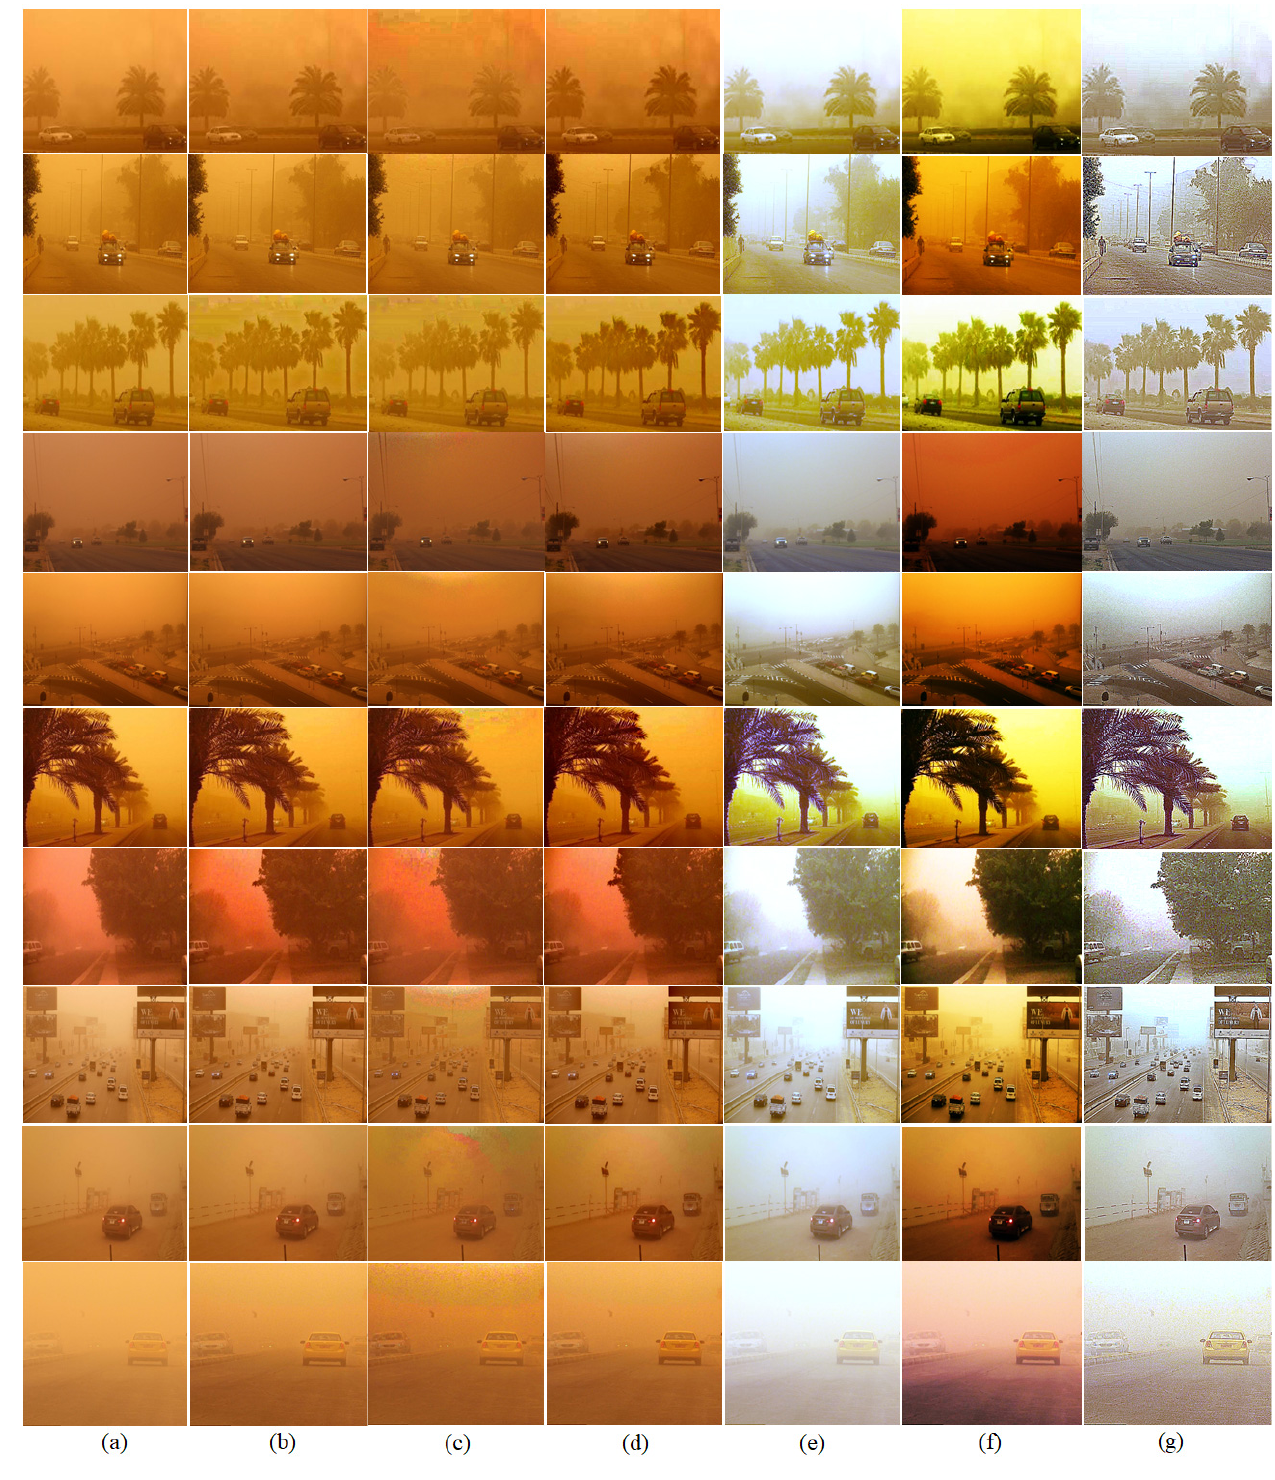
Figure 7. The comparison of the enhanced image with state-of-the-art methods and the proposed method on severely degraded duststorm images: ( a ) Input image; ( b ) He et al. [1]; ( c ) Meng et al. [2]; ( d ) Ren et al. [15]; ( e ) Gao et al. [7]; ( f ) Al Ameen [4]; ( g ) Proposed method.